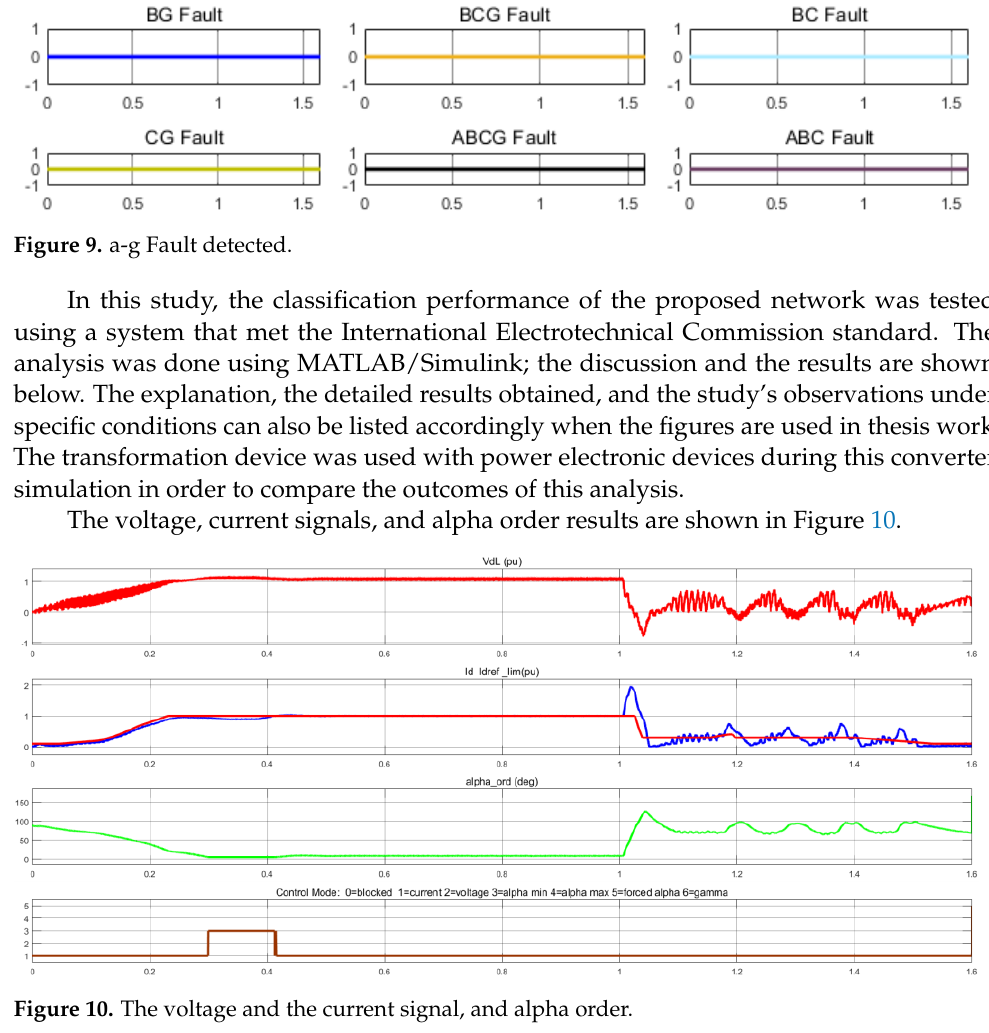
Figure 11. Three-phase voltage and current signals. As seen in Figure 11, the faulted signal occurred in the first second of the simulation. In Figure 11, the (X) axis shows the simulation time, and the (Y) axis shows the voltage and current amplitude value. Figure 12 shows the reliable state condition at the rectifier section without any abnormal behavior in DC.